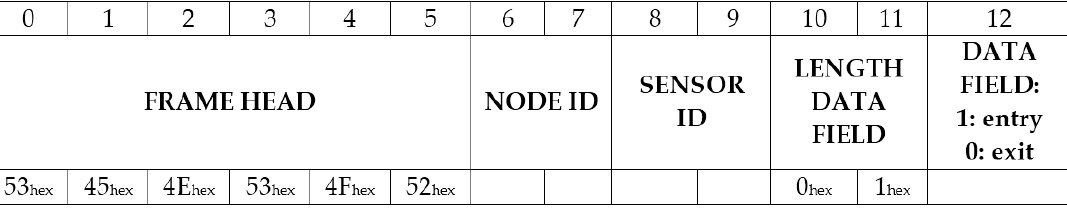
Figure 10. Structure of data packet sent by the sensor nodes to notify vehicle entry or exit.